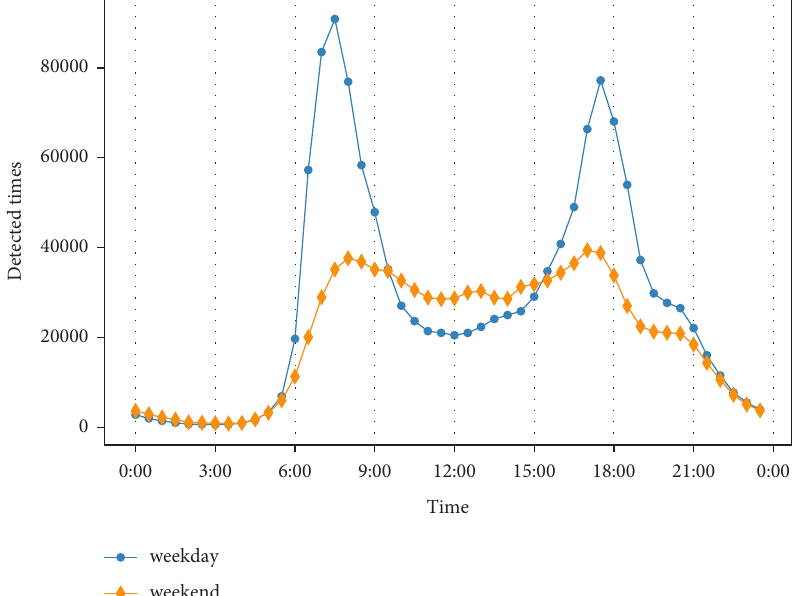
Figure 3: The detected frequency distribution of commuting pattern vehicles on weekdays and